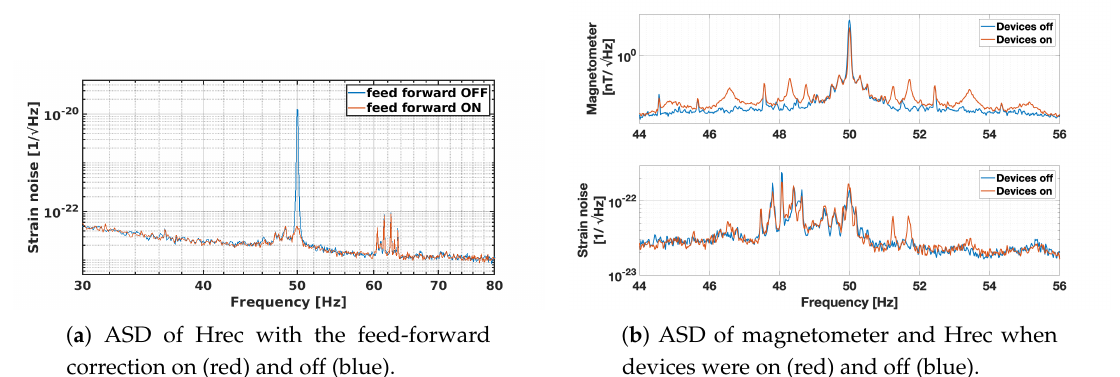
( a ) ASD of Hrec with the feed-forward correction on (red) and off (blue). Figure 9. ( a ) Feed-forward subtraction of 50 Hz noise. ( b ) Removal of 50 Hz sideband